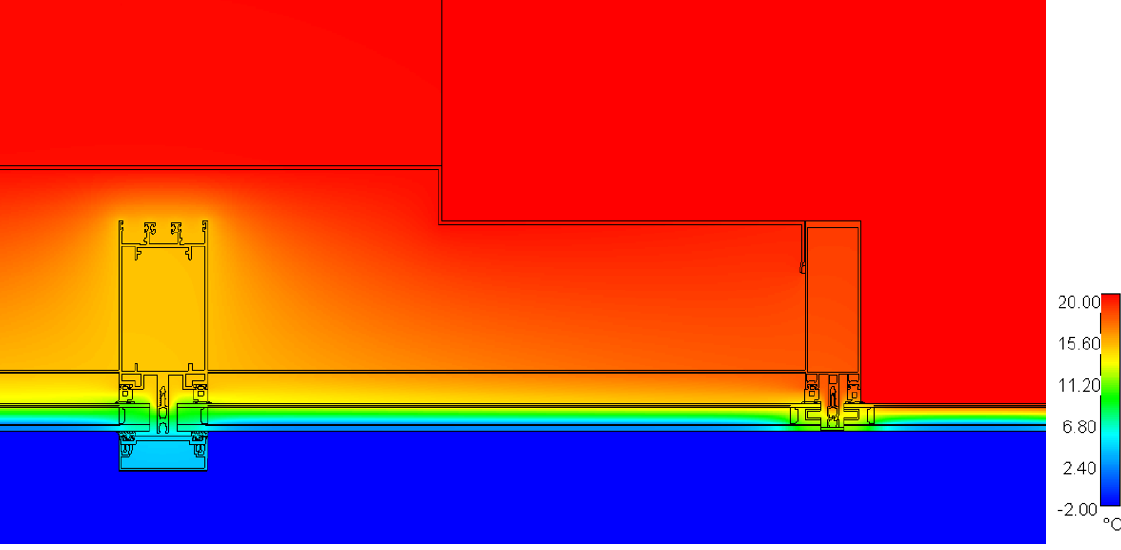
Fig. 10: MIN. TEMPERATURE IN WINTER – 2D